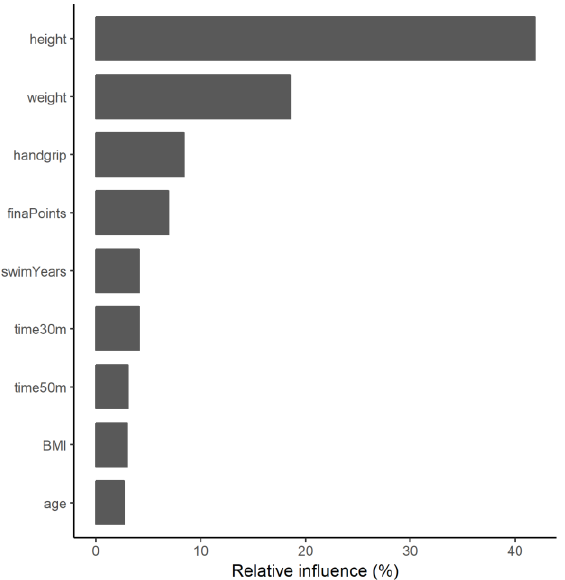
Figure 1. Relative contribution of the main variables of the ensemble model.